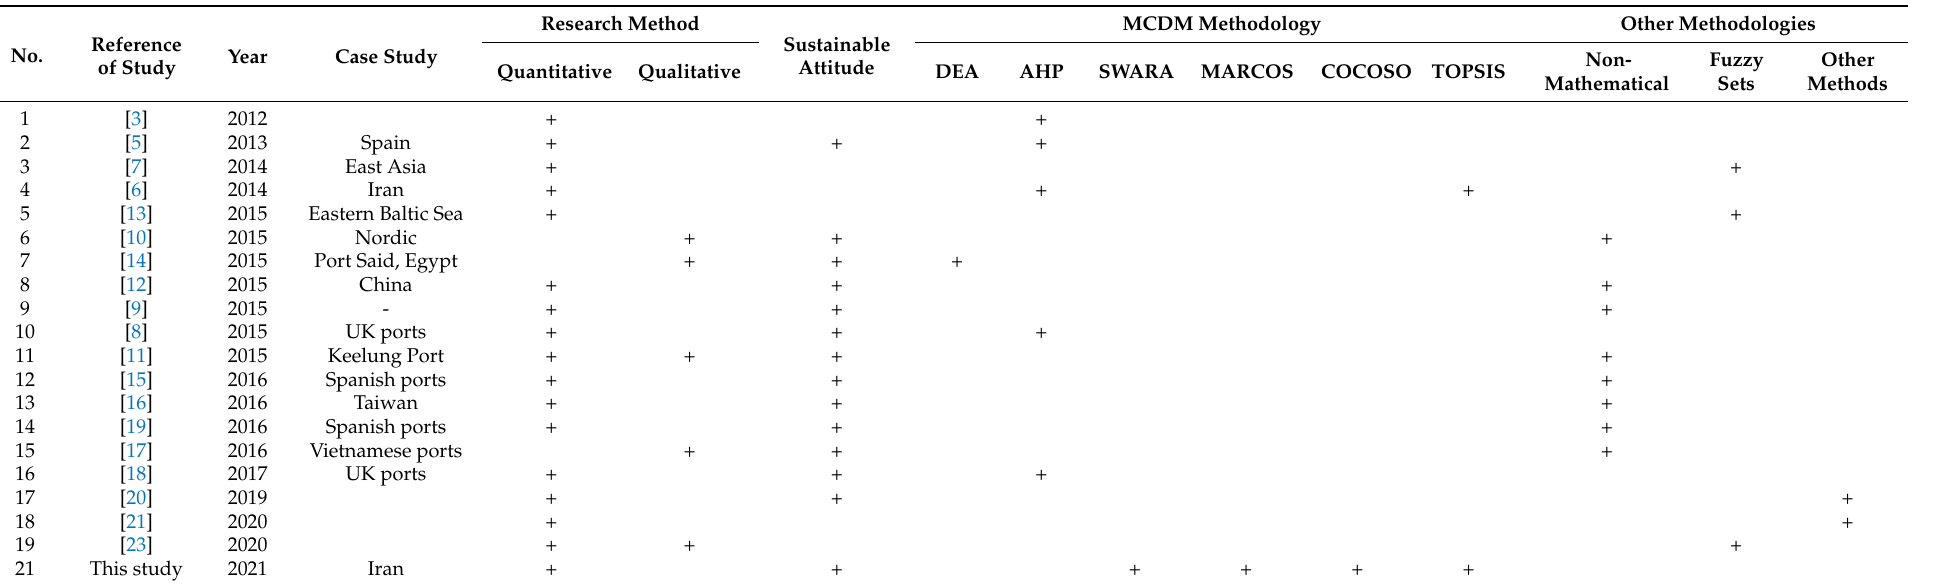
Table 2. The major recent procedures in the maritime supply